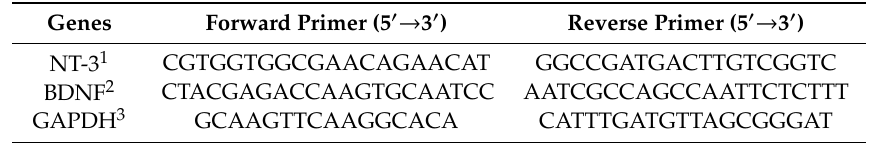
Table 1. Apoptotic primer sequence used for qRT-PCR